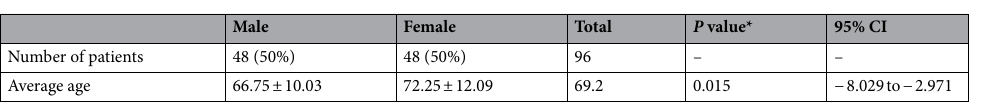
Table 1. Basic information of recruited outpatients. *Independent t-test was employed between